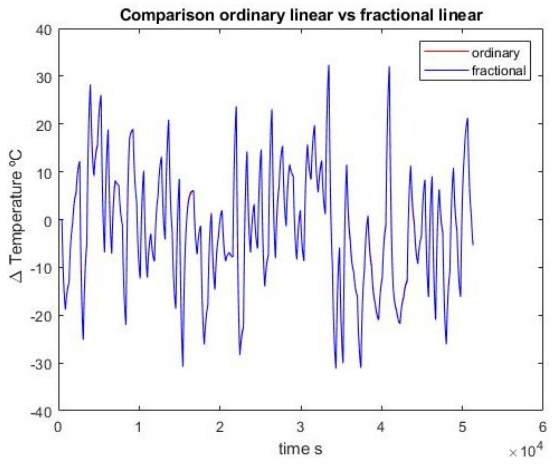
Figure 8. First-order models comparison with identification data.